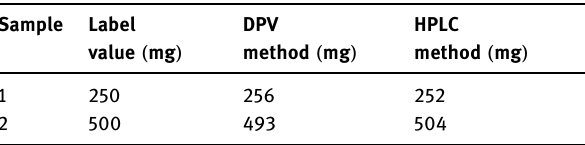
Table 4: Detection of NPX in pharmaceutical tablets by the pro - posed DPV and HPLC methods